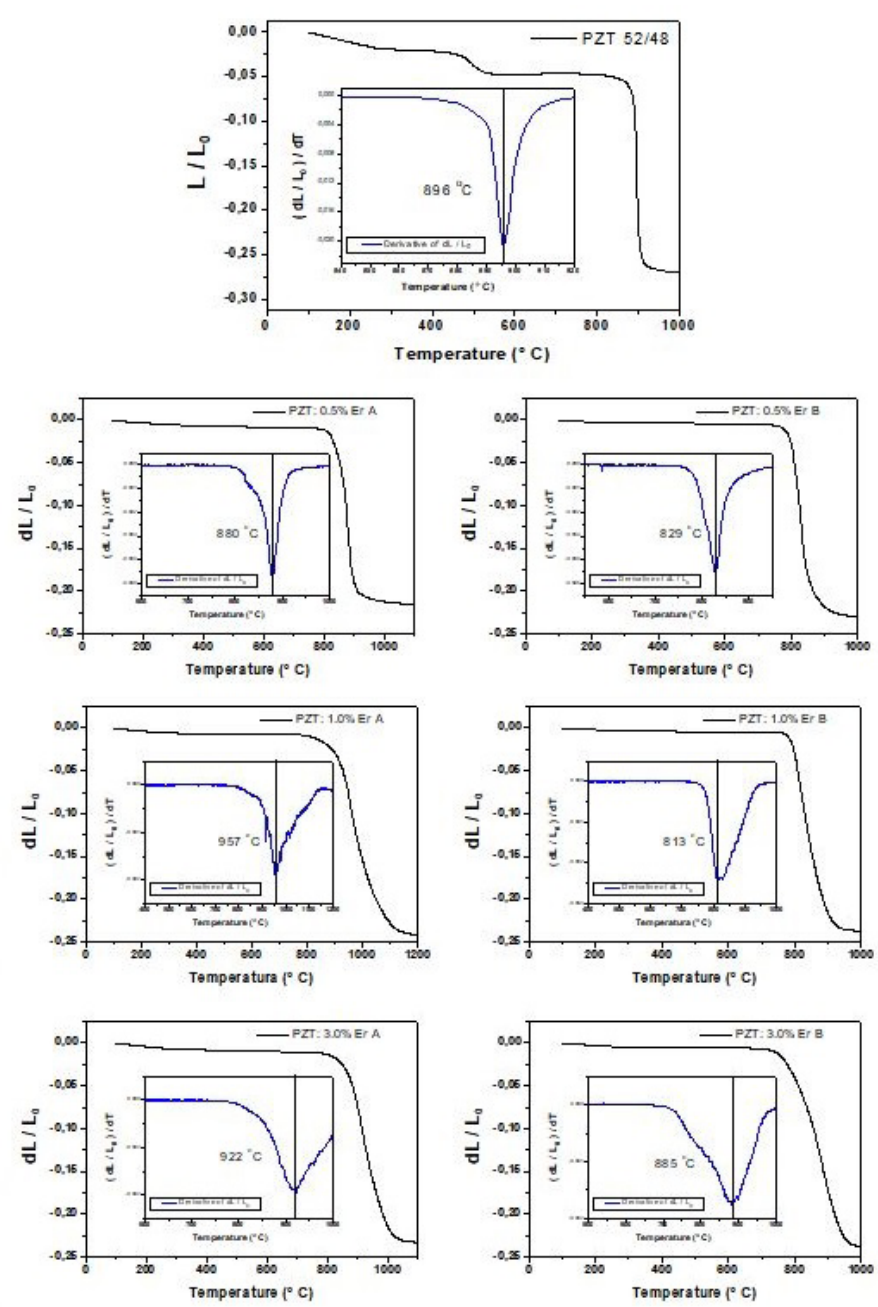
Figure 6. Dilatometric results of all